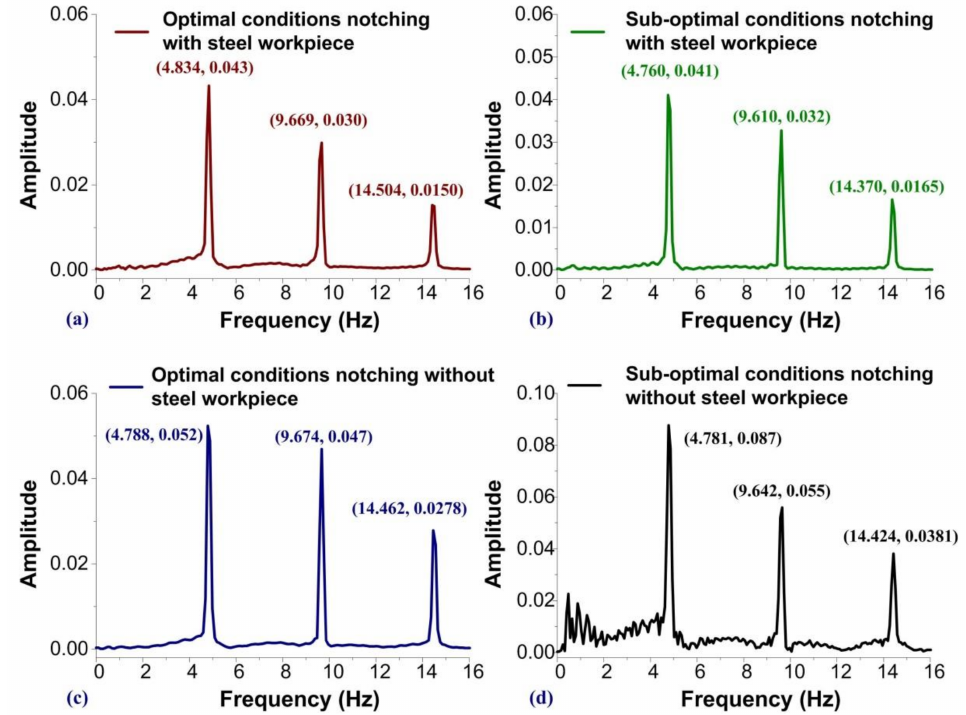
Figure 8. Comparison of the frequency spectra of measured PVDF signals: signals obtained with a steel workpiece loaded into the notching machine with ( a ) sharp edges and ( b ) blunt edges; and signals obtained without a steel workpiece loaded into the notching machine with ( c ) sharp edges and ( d ) blunt